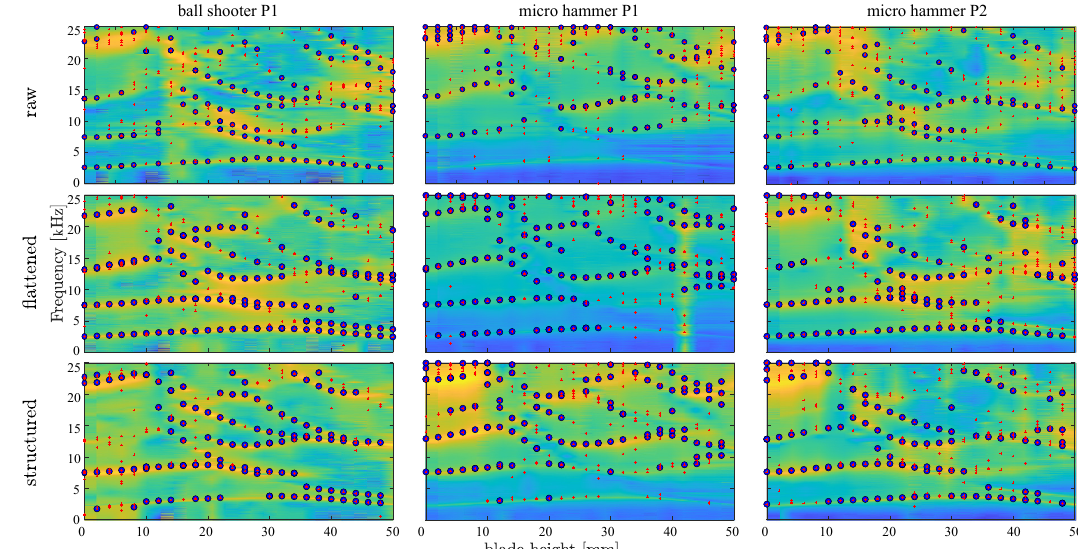
Figure 12. The measured averaged Frequency Response Function in the function of the blade height presented as a waterfall diagram. The colour scale denotes the logarithmic amplitude of the averaged FRF, the red crosses denote all the fitted natural frequencies by means of the ISD method for each excitation and the blue circles denote the consistent fitted natural frequencies.